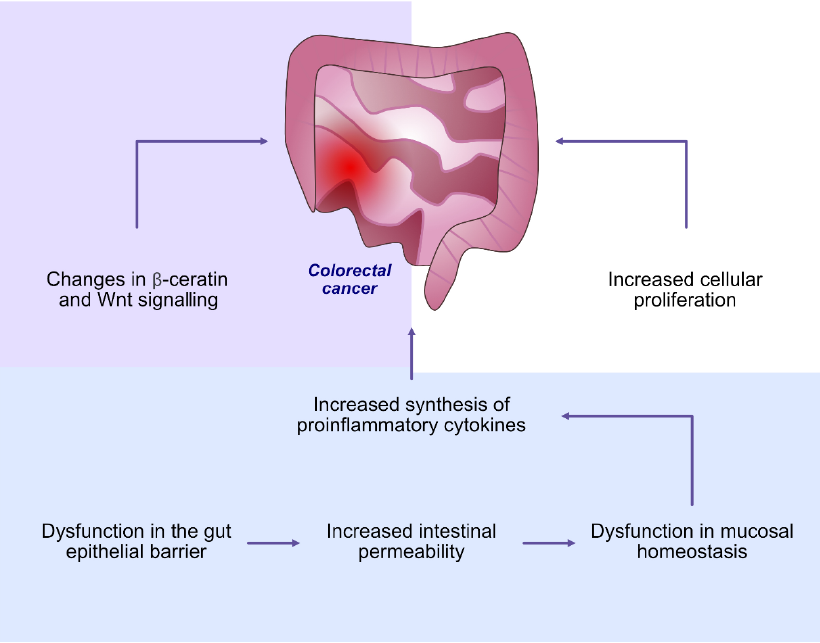
Figure 5. The involvement of oral microbiome dysbiosis in the development of colorectal cancer.